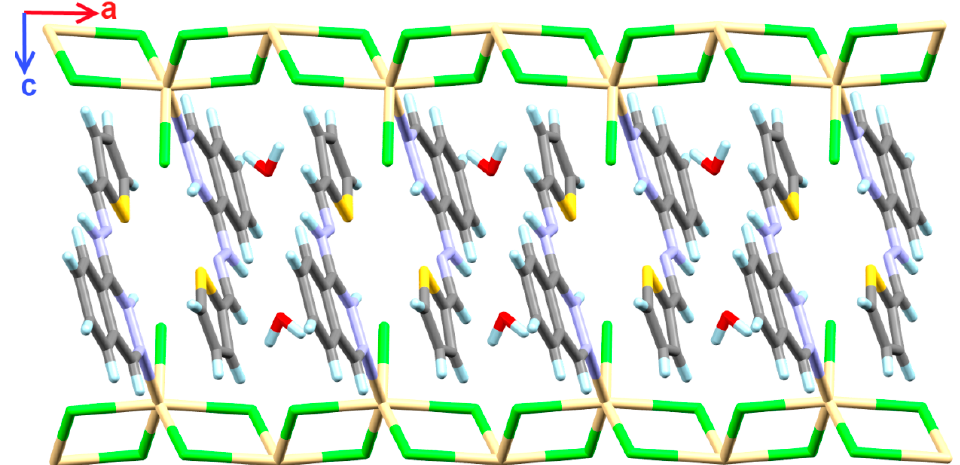
Figure 4. The 1D coordination polymer extended along the crystallographic a -direction via the Cd-Cl1/Cl2 interactions.